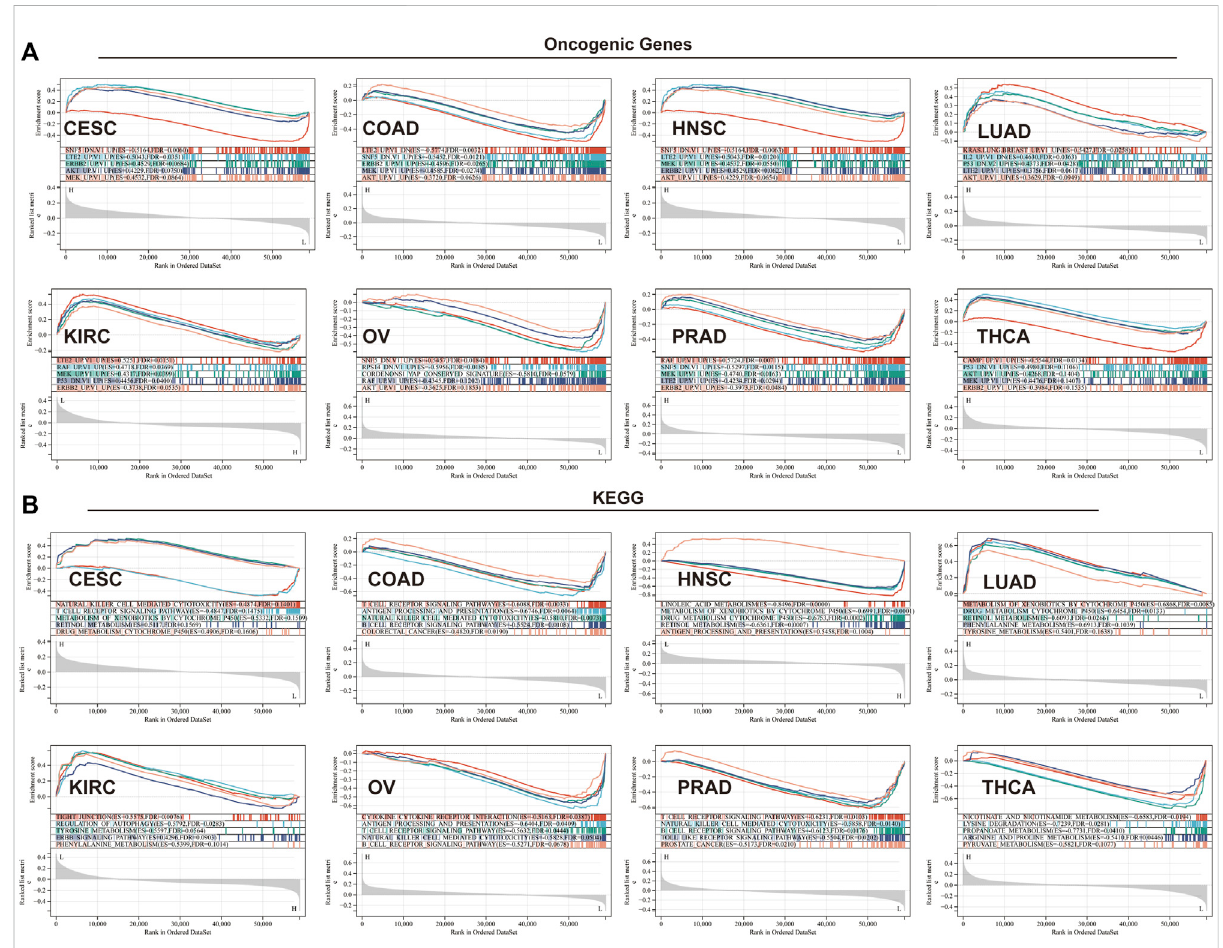
FIGURE 9 GSEA in eight cancer types. (A) Oncogenic functional annotation of TGM3 in eight cancer types. (B) KEGG pathway analysis of TGM3 in various cancers. Colored curves indicate signi fi cant functions or pathways screened for different tumors. Peaks on the ascending curve (top enrichment) indicate positive association, while peaks on the descending curve (bottom enrichment) indicate negative